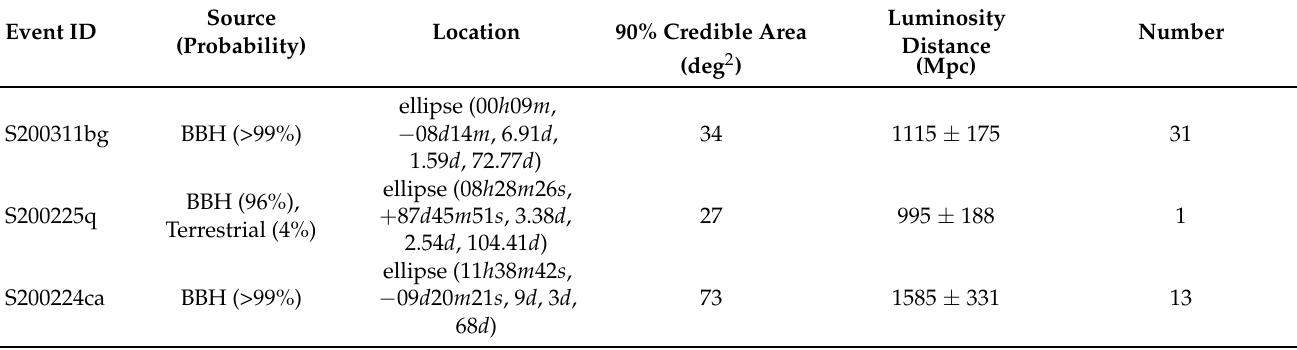
Table 1. Information for seven BBH merger events, where column 6 provides the number of galaxy targets found in